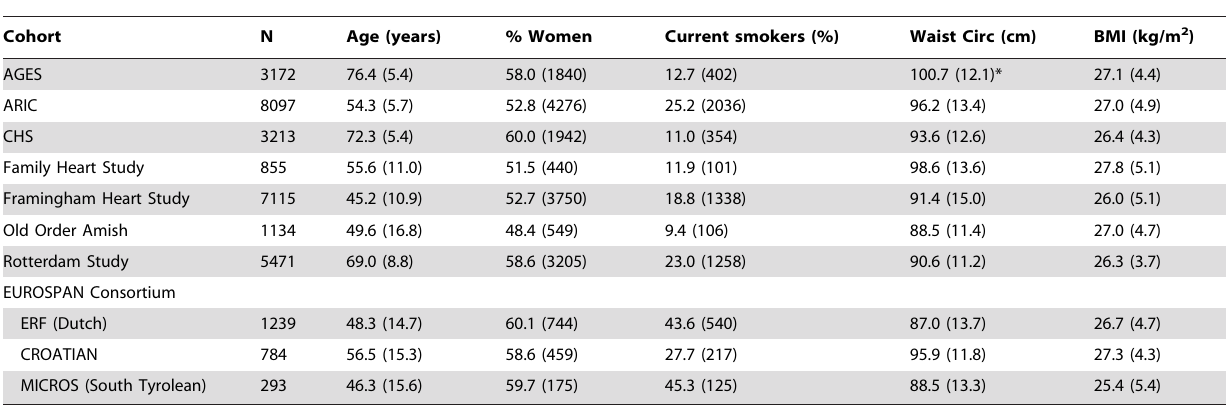
Table 1. Descriptive statistics across the eight